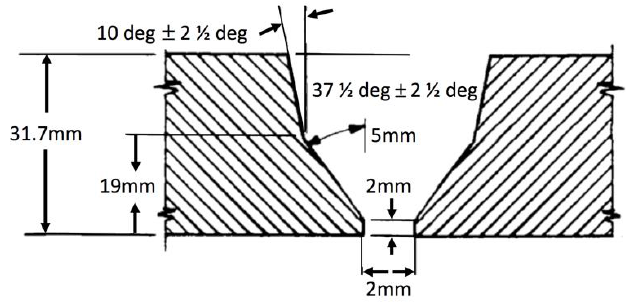
Figure 1. Design of the 9% Ni steel circumferential pipe butt joint.